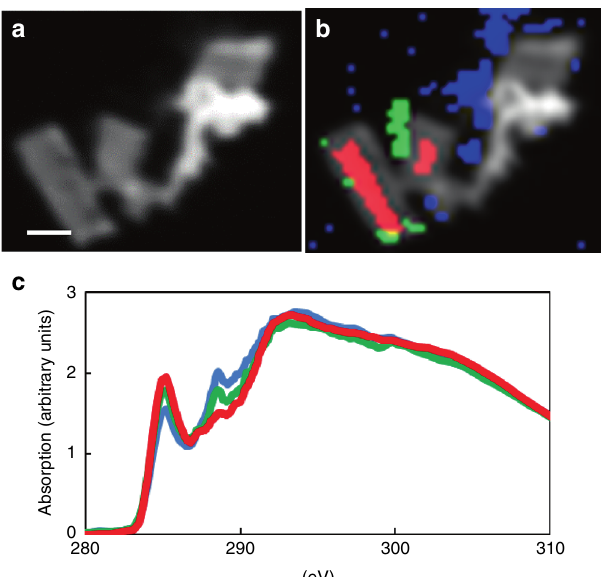
Fig. 4 Scanning transmission X-ray microscopy of co-composted biochar. a Average image on linear absorbance scale (optical density) calculated from a stack across the C1s absorption edge (278 – 330 eV) of an ultra-thin section of co-composted biochar. Scale bar, 500 nm. b C1s stack with overlay of regions of interest for downstream data evaluation: green — regions on or directly adjacent to the two biochar particles with relatively high N/C ratio (based on X-ray absorption ratio), red — manually de fi ned region of the particle center, blue — all regions in the analyzed area with high N/C ratio, includes the green marked region. Same scale as a . c X-ray absorption spectra extracted from the regions de fi ned in b with the respective colors, the blue spectrum again includes the green region. Spectra reveal a relative increase in absorption at the 1s-pi* transition (288.6 eV; R-COOH; CO 62 ) from particle center (red) to particle associated high N/C (green) to all areas with high N/C (blue). In-depth analysis of this and two other regions of interest is displayed in Supplementary Fig. 3B, C. Comparison of with pristine biochar is displayed in Supplementary Fig.